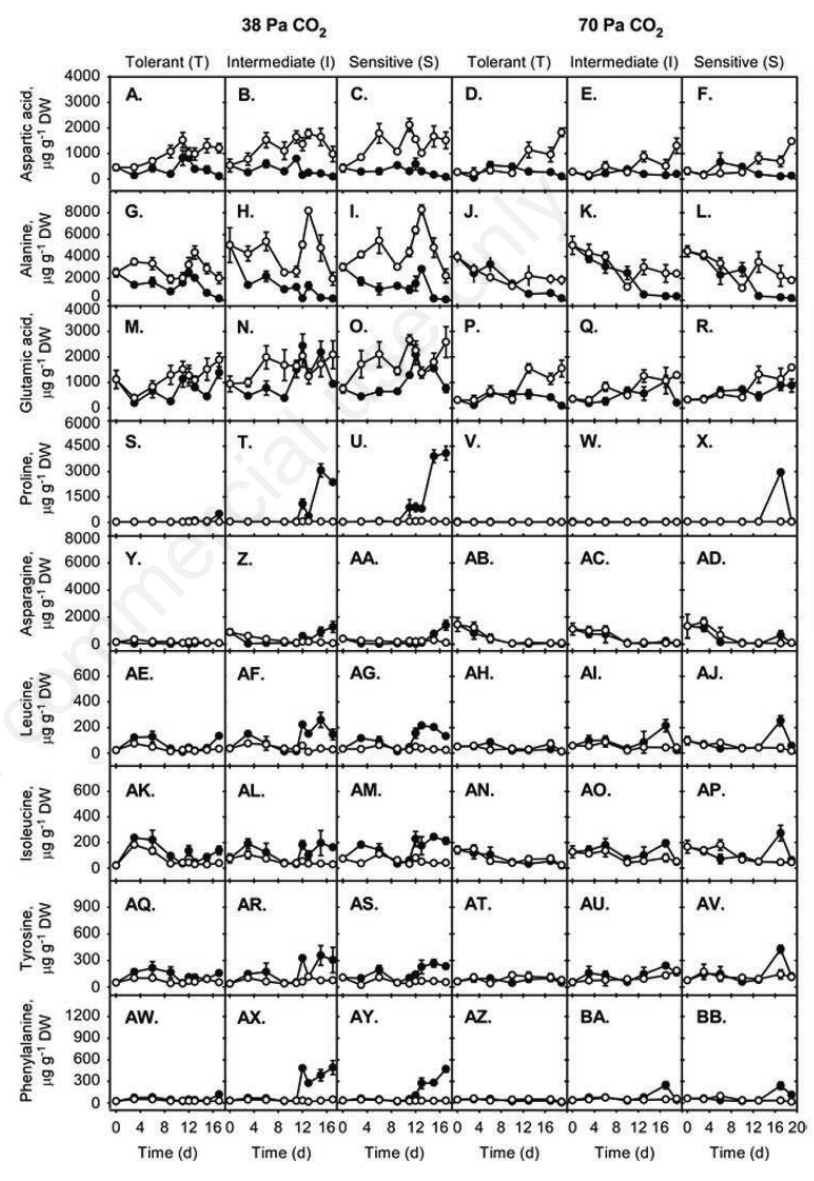
Figure 3. Effects of water stress and CO enrichment on soluble amino acids in leaves of 2 three maize hybrids differing in drought susceptibility. Changes of nine individual amino acids ( g g –1 DW) in leaves of intermediate, tolerant and sensitive maize hybrids are shown during progressive drought treatment for 19 d. Results are for water sufficient μ ( ) and water insufficient ( ) plants raised in ambient (first three columns) or elevated (last three columns) CO . Values are means ± standard error for eight samples from two ○ ● 2 fully replicated